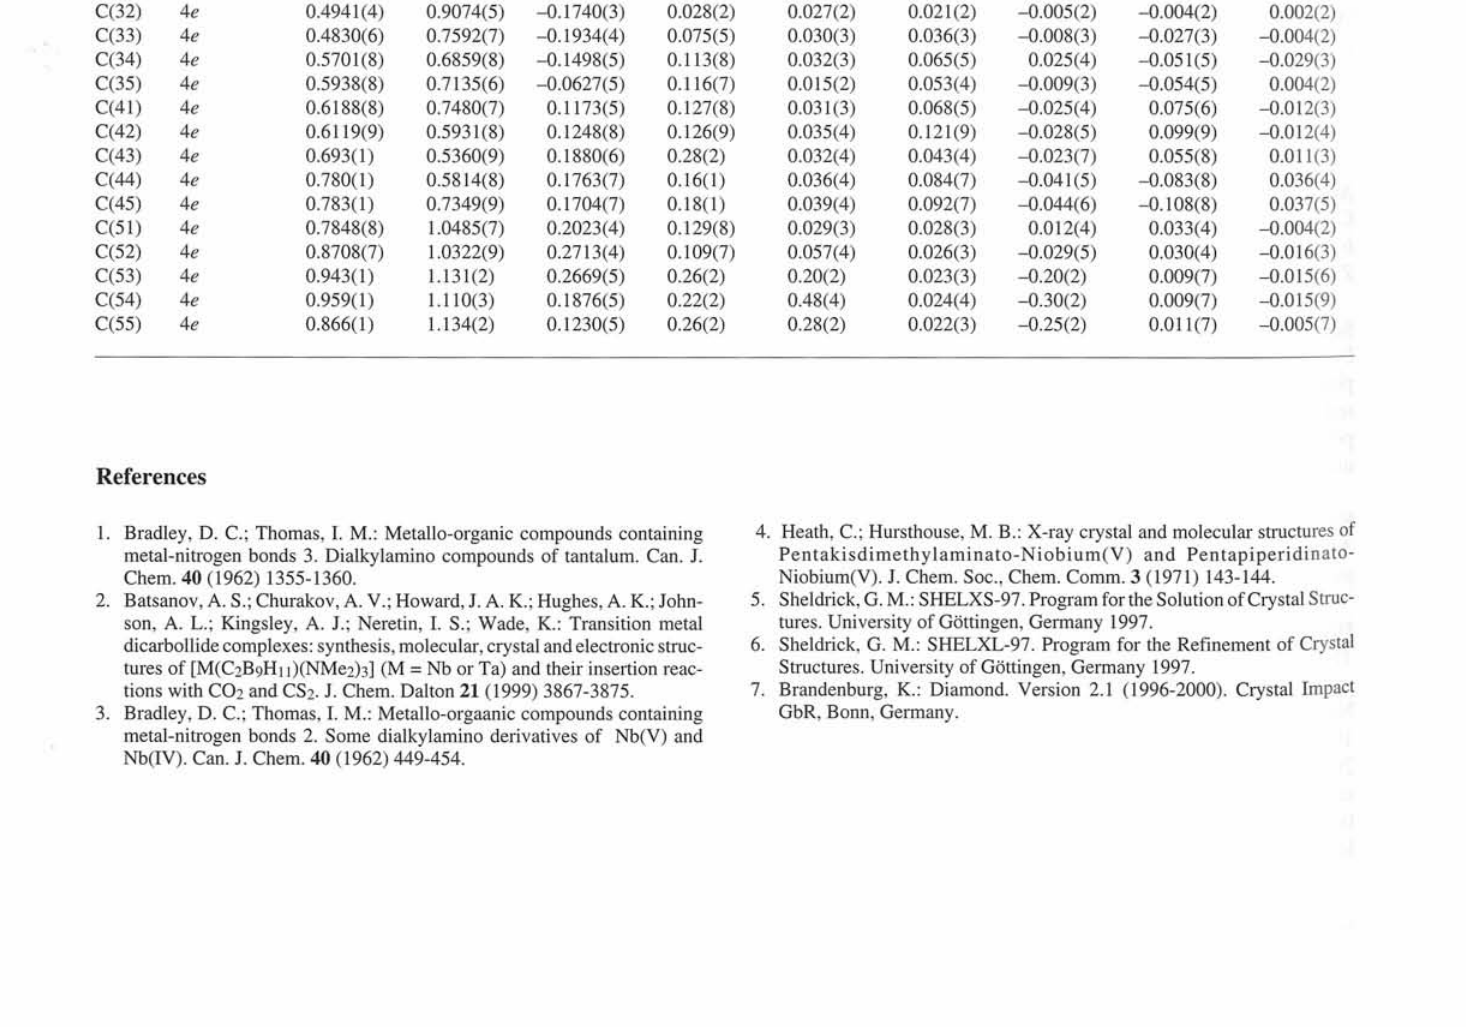
Table 3. Atomic coordinates and displacement parameters (in À 2